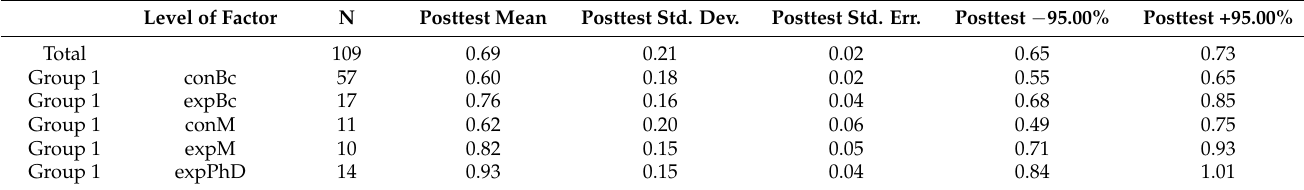
Table 7. Descriptive statistics for the posttest, taking into account the degree of